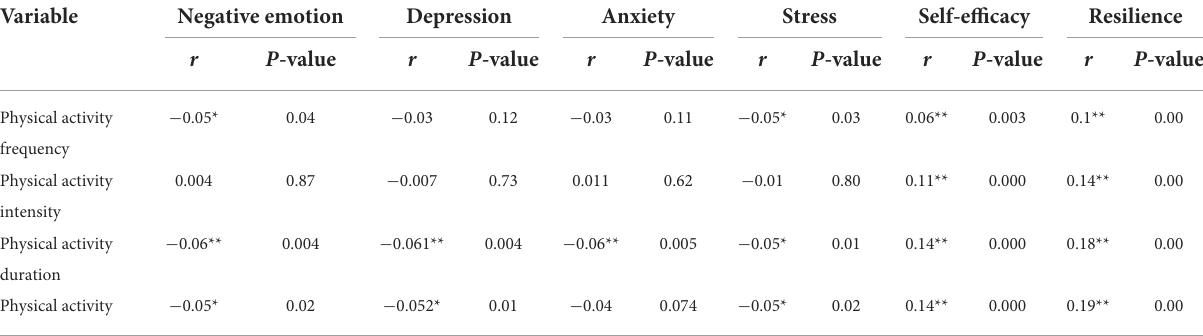
TABLE 4 The relationship between physical activity on negative emotion, depression, anxiety, stress, self-efficacy, and resilience in medical postgraduate students in China.